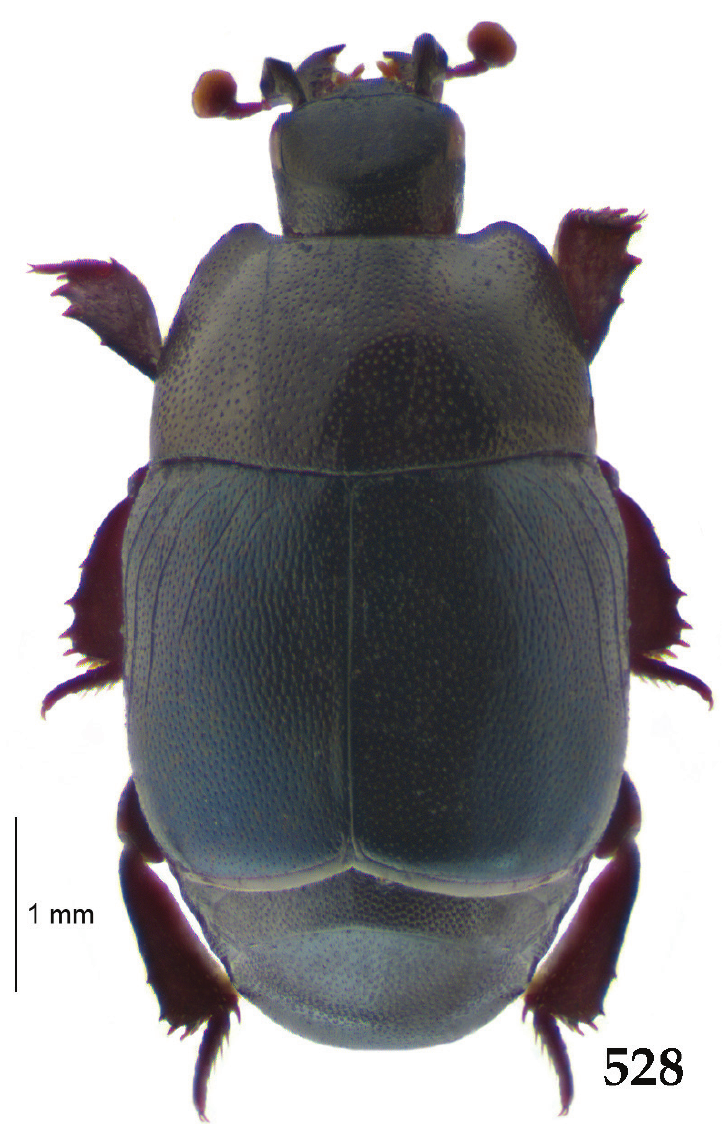
Figure 528. Saprinus ( Saprinus ) rarus sp. n. habitus, dorsal view. Description. Body length: PEL: 3.50 mm; APW: 1.50 mm; PPW: 2.50 mm; EL: 2.25 mm; EW: 2.90 mm (only one specimen was measured). Body (Fig. 528) elongate, convex, pronotum distinctly narrower than elytra, pronotum piceous, shining, elytra dark blue with metallic tinge; legs, mouthparts and antennal scape+funicle chestnut brown, antennal club lighter, amber colored, becoming pro- gressively lighter